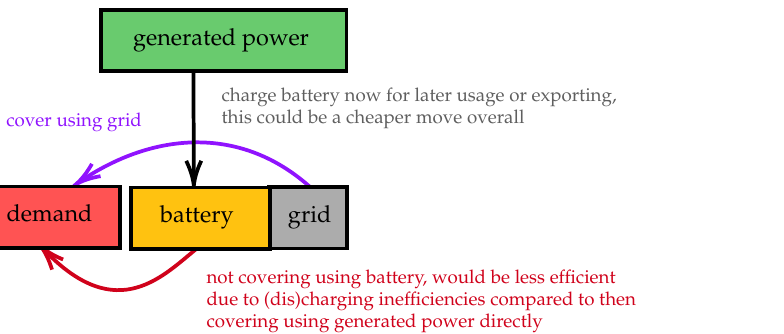
Figure 2. Scenario in which generated power is used first to cover demand, either in case of excess power (more generated power than demand) or excess demand (less generated power than demand).